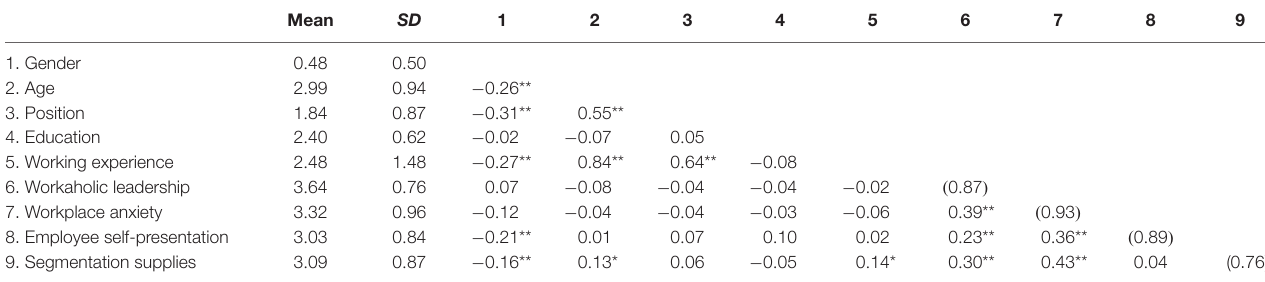
TABLE 1 | Means, standard deviations, and correlations between the study variables. Mean SD